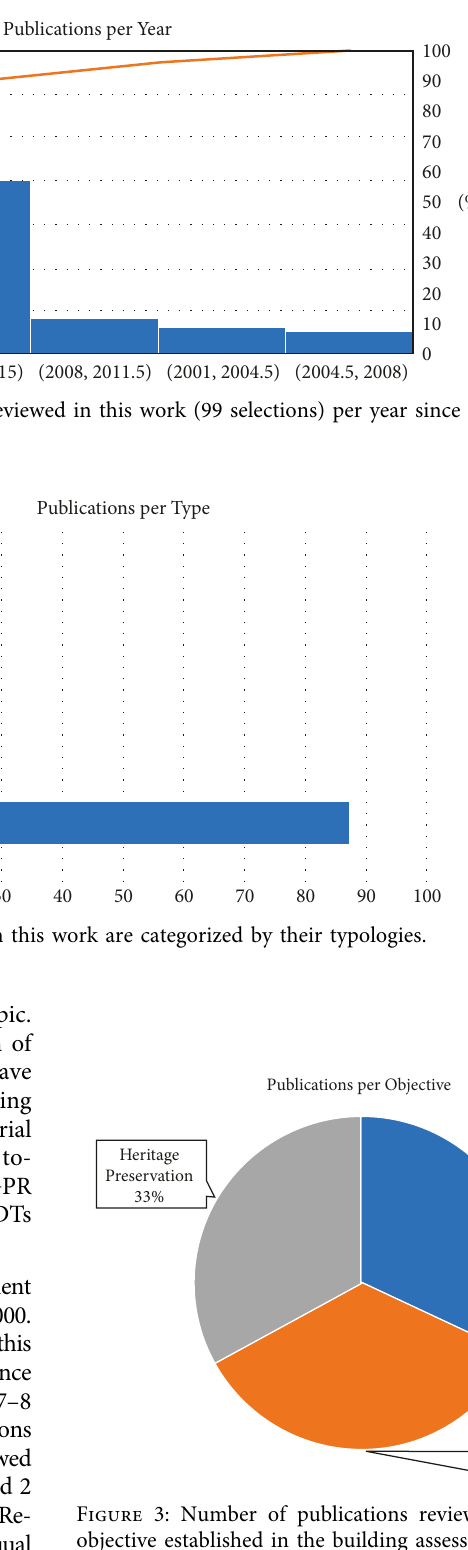
Figure 3: Number of publications reviewed that address each objective established in the building